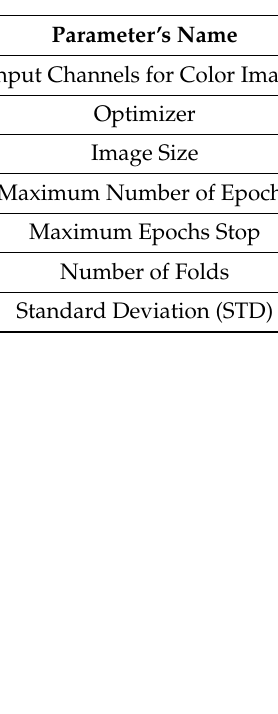
Table 3. Hyperparameters for all classification